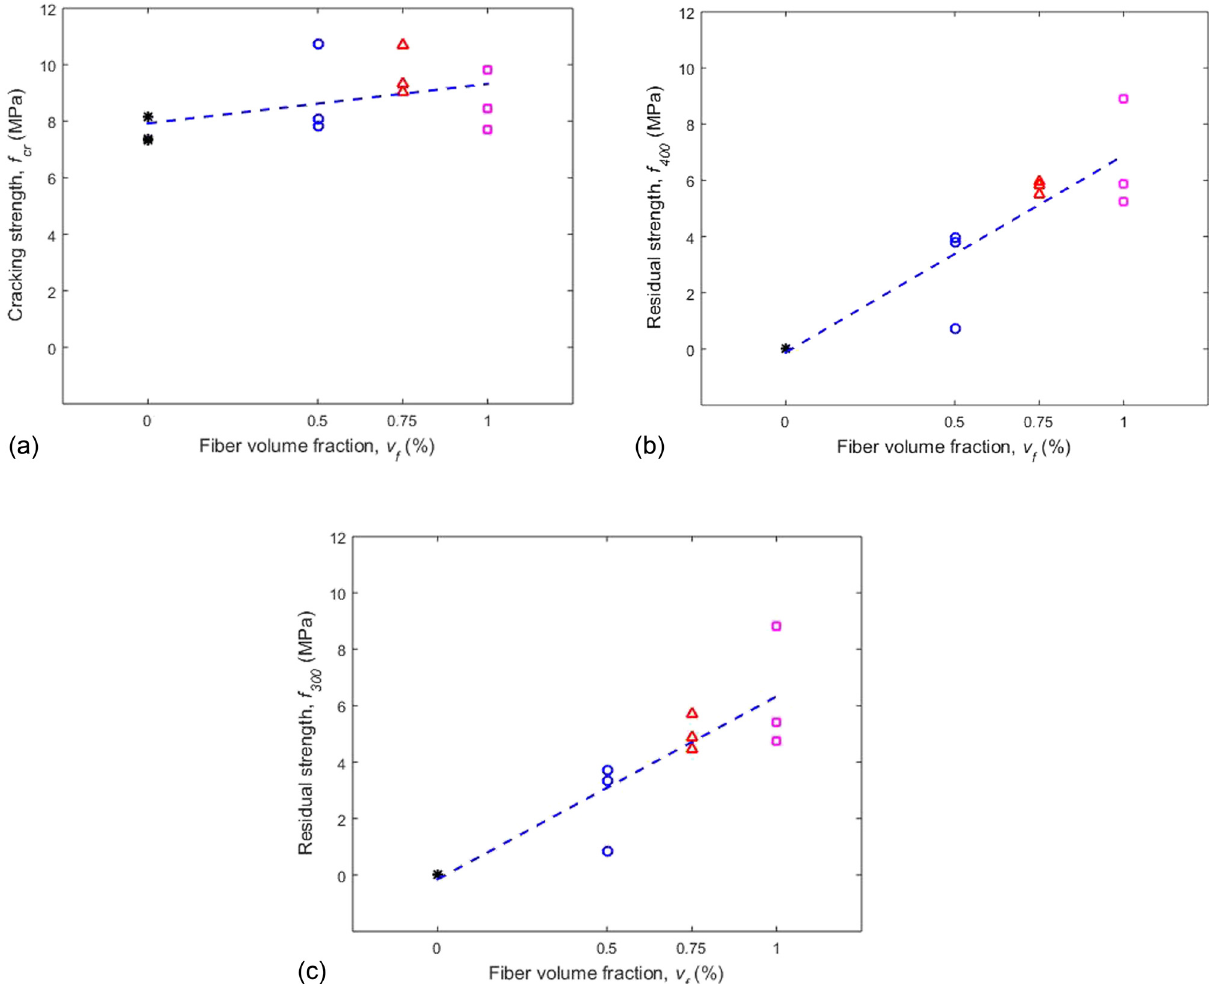
Figure 8: Residual fl exural strengths of the beam specimens with fi ber volume fractions: ( a ) f cr , ( b ) f 400 , and ( c ) f 300